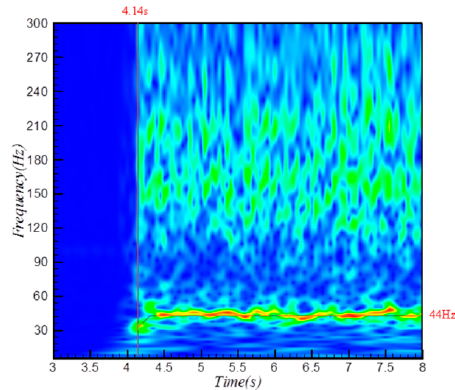
Figure 10. Time-frequency analysis of the grayscale of line L.